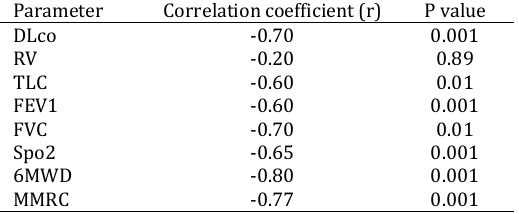
Table 4. The correlation of Warrick score and important pulmonary function test parameters in scleroderma lung fibrosis Parameter Correlation coefficient